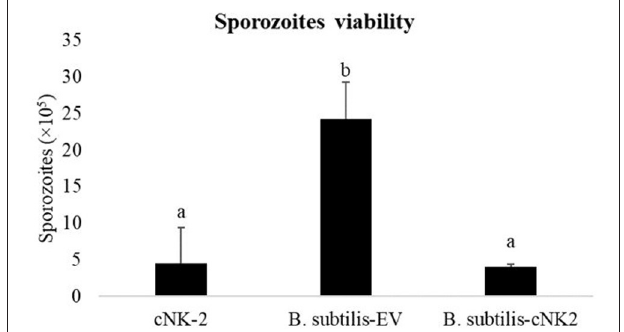
FIGURE 2 | Effect of B. subtilis expressing empty vector ( B. subtilis -EV) or chicken NK2 ( B. subtilis -cNK-2) in vitro . Eimeria acervulina sporozoites (1.0 × 10 7 /mL) were incubated with culture supernatant from B. subtilis -EV or B. subtilis -cNK-2 for 3h at 41 ◦ C. Chicken NK-lysin (cNK-2) was used as control at a concentration of 100 µ g/mL. Sporozoites were stained with a fluorescence viability dye and viable sporozoites were counted microscopically. a,b Bars with no common letter differ significantly ( p <